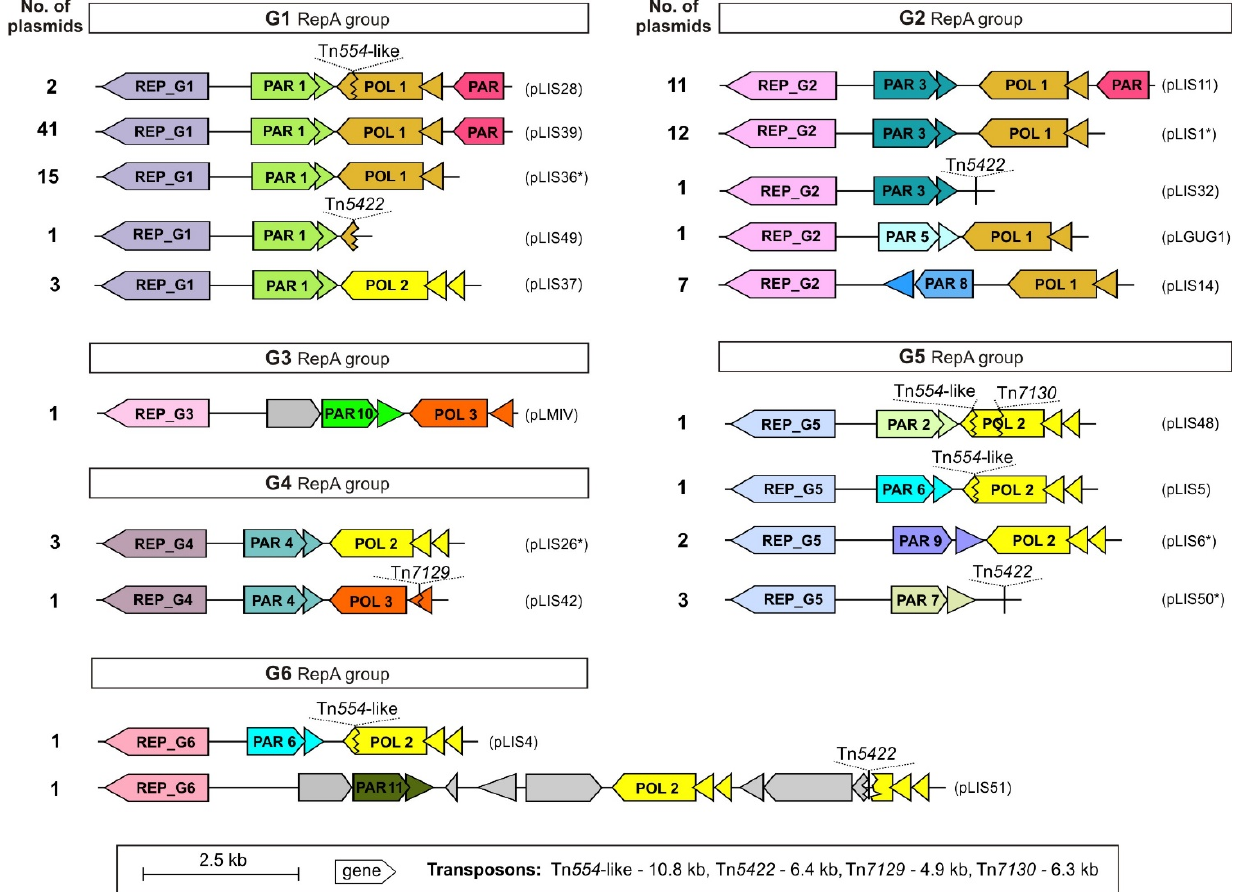
Figure 3. Genetic organization of the conserved backbone of Listeria repA -family plasmids, composed of replication (REP), partitioning (PAR) and Y-family polymerase (POL) genetic modules. Number of plasmids with similar genetic organization of backbones is indicated on the left while names of example plasmids are presented on the right. Transposon insertion sites are marked. Stars indicate plasmids whose REP systems were subjected to host range analysis. Phylogenetic trees of the RepA, ParA and UvrX protein sequences, supporting their classification into individual groups, are presented in Figures S1, S4 and S5.